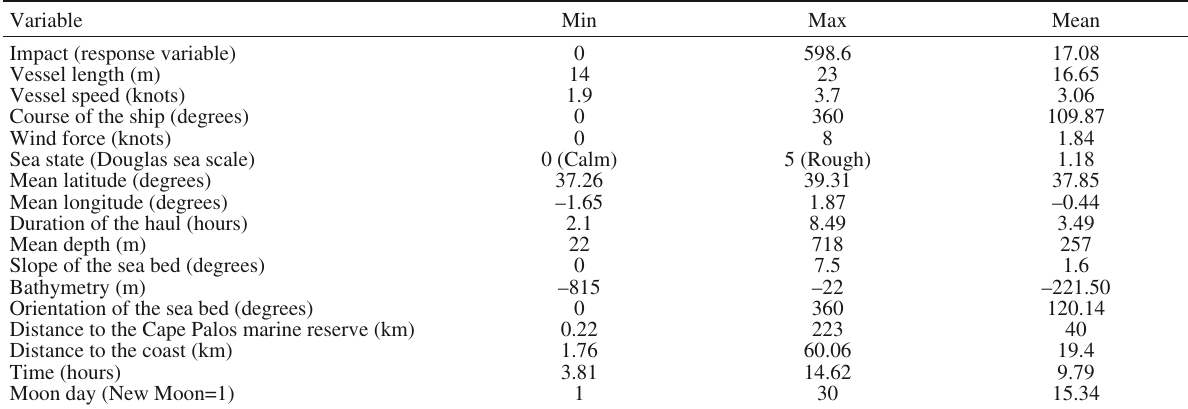
Table 1. – Numerical variables.